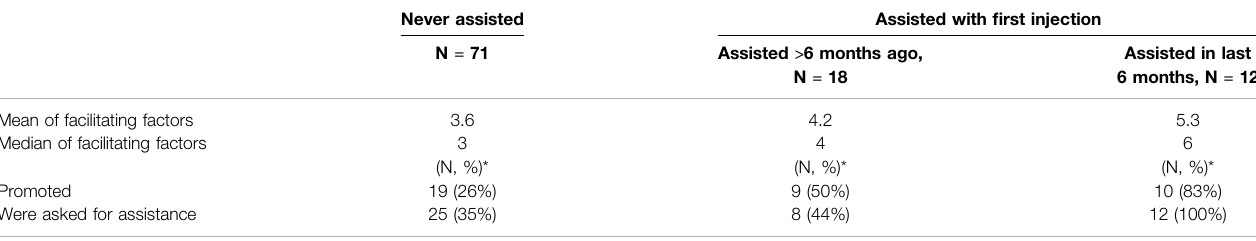
TABLE 4 | Comparison of promoting behaviors and being asked to help among those who had never helped someone inject, those who had helped prior to previous 6 months, and those who in the last 6 months among PWID in Staten Island.